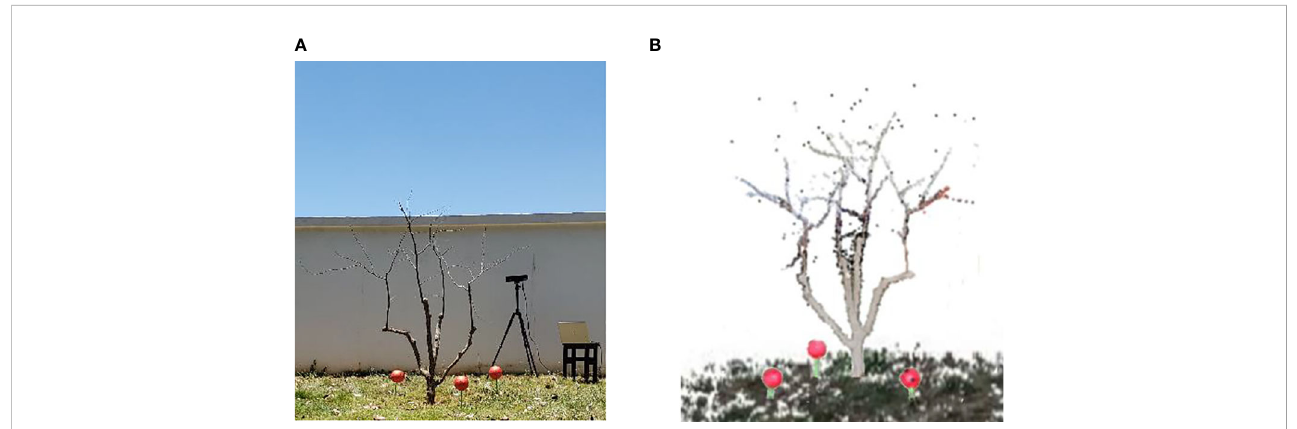
FIGURE 1 Data acquisition. (A) Experimental scene. (B) Original color point cloud image on one side.